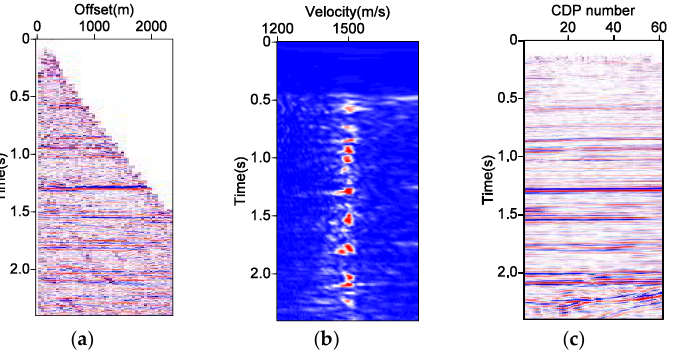
Figure 1. Consistency between energy clusters in velocity spectrum and formation interfaces. ( a ) CDP gather at CDP 30; ( b ) velocity spectrum generated from the gather shown in Figure 1a; ( c ) stack section.